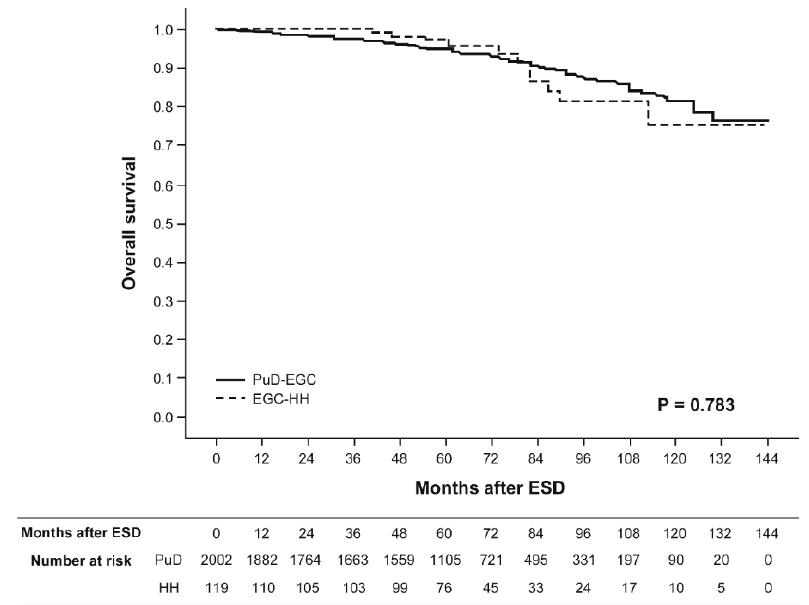
Figure 3. Kaplan–Meier overall survival curves for patients undergoing curative endoscopic submucosal dissection. Solid line, pure differentiated-type early gastric cancer (PuD-EGC); dotted line, differentiated-type-predominant early gastric cancer with histological heterogeneity (EGC-HH).